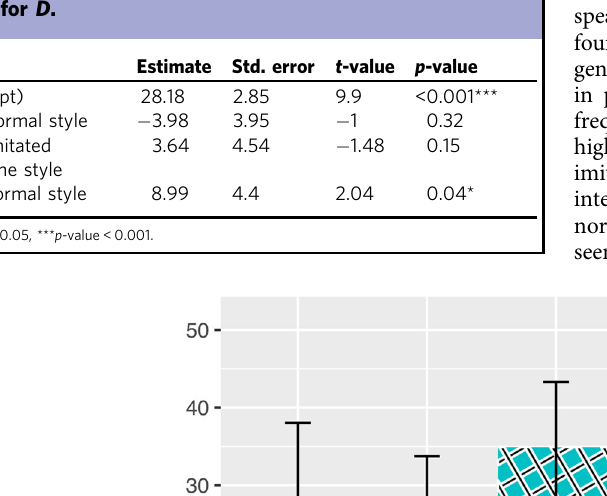
Table 11 Results of the linear-mixed-effects regression model for D .